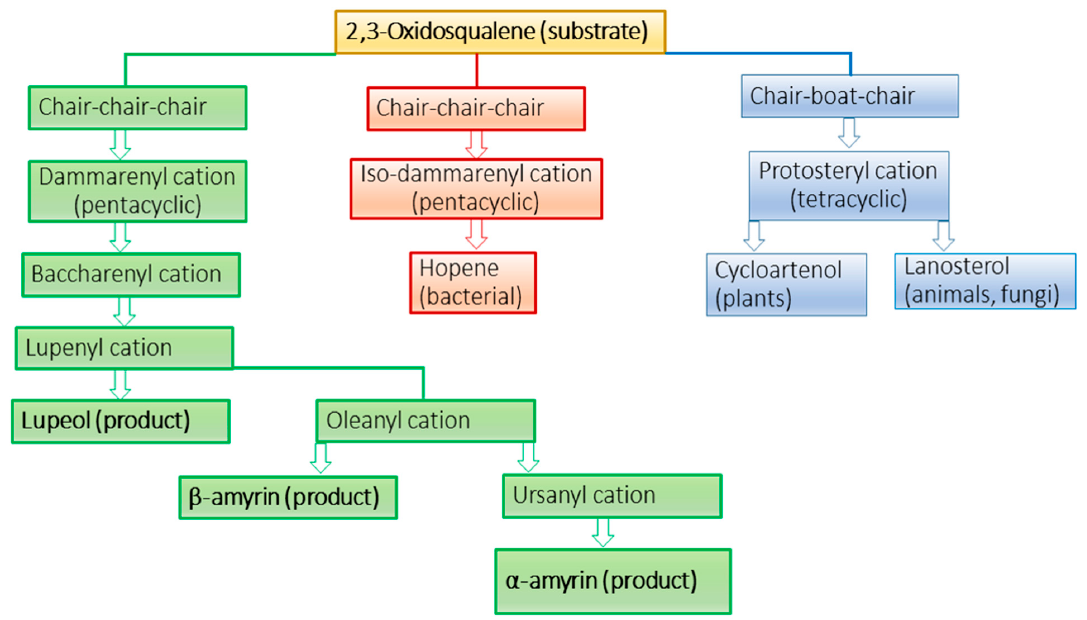
Figure 7. Conversion of substrate to various products via cation intermediates in fruits compared to that in other organisms, according to the previous literature [10,20,28]. The three main routes are colored green, pink and blue based on various triterpene skeletons. Products of OSCs (amyrins) can subsequently be converted to oleanolic and ursolic acids by C ‐ 28 oxidases.